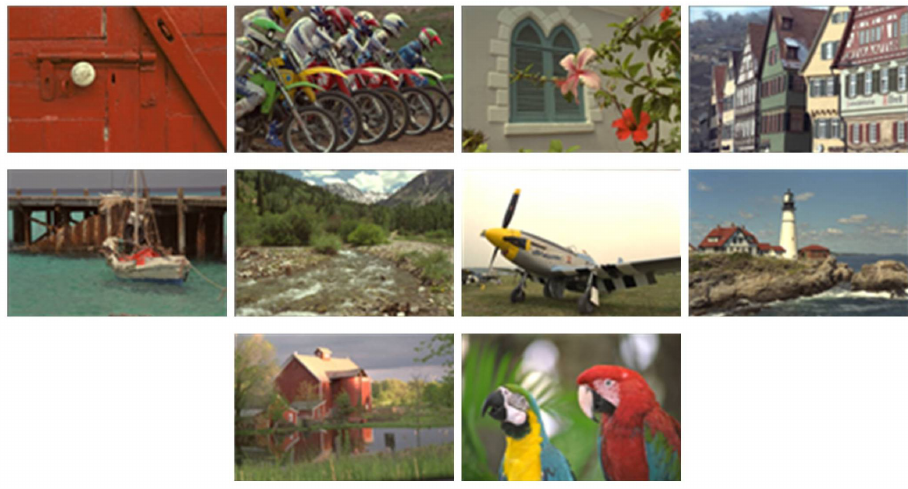
Figure 4. Kodak Test